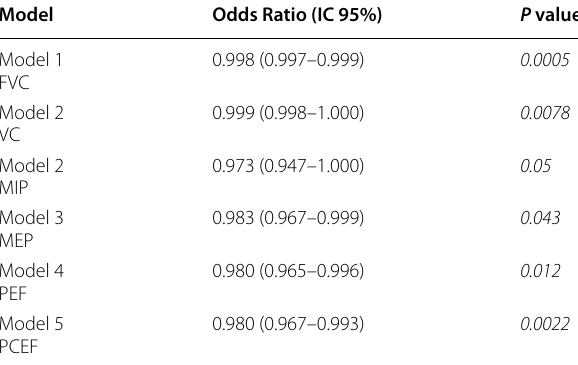
Table 4 Multivariate analysis of extubation predictors